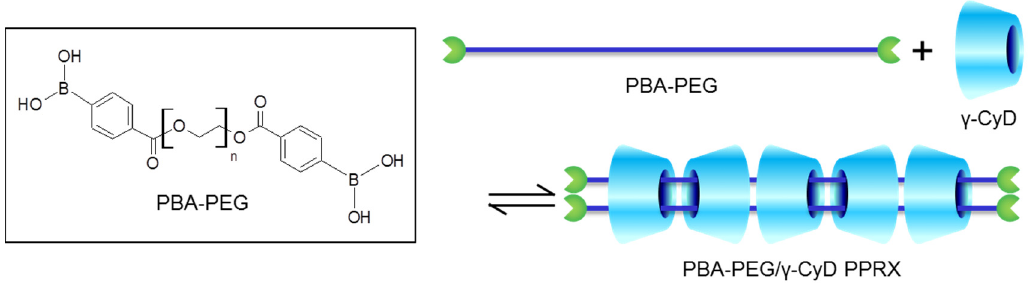
Figure 1. Chemical structure of phenylboronic acid-modified polyethylene glycol (PBA–PEG) and schematic illustration of PEG-PBA/ γ -cyclodextrin pseudopolyrotaxane ( γ -CyD